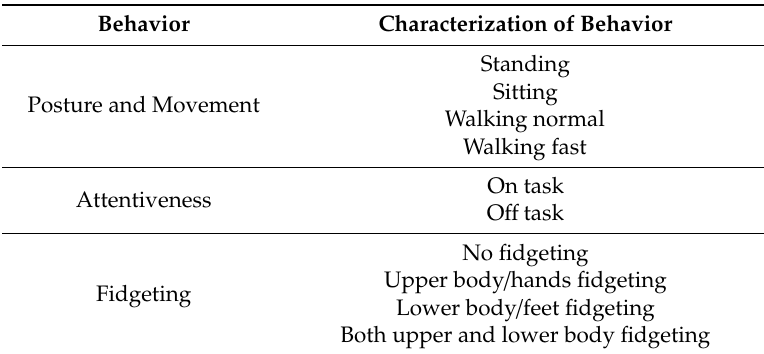
Table 1. Description of Direct